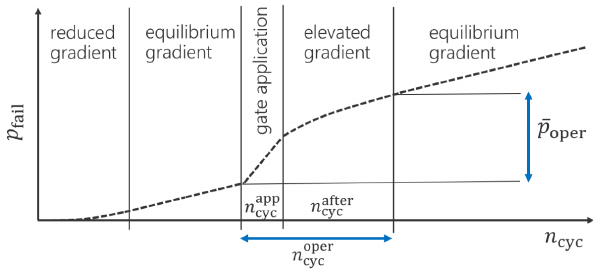
FIG. 15. Sketch of the cumulative failure probability before, during, and after a logical operation. Logical preparations and measurements comprise only some parts of this sketch. Before we apply the operation, we first make sure that the system reaches QEC equilibrium. The logical operation, which would take n app cyc cycles by itself, is augmented with n after idle cycles to ensure the cyc system has returned to QEC equilibrium afterwards. The logi- is the increment of p fail over the cal operation failure rate p oper QEC cycles. n oper cyc = n app cyc + n after cyc